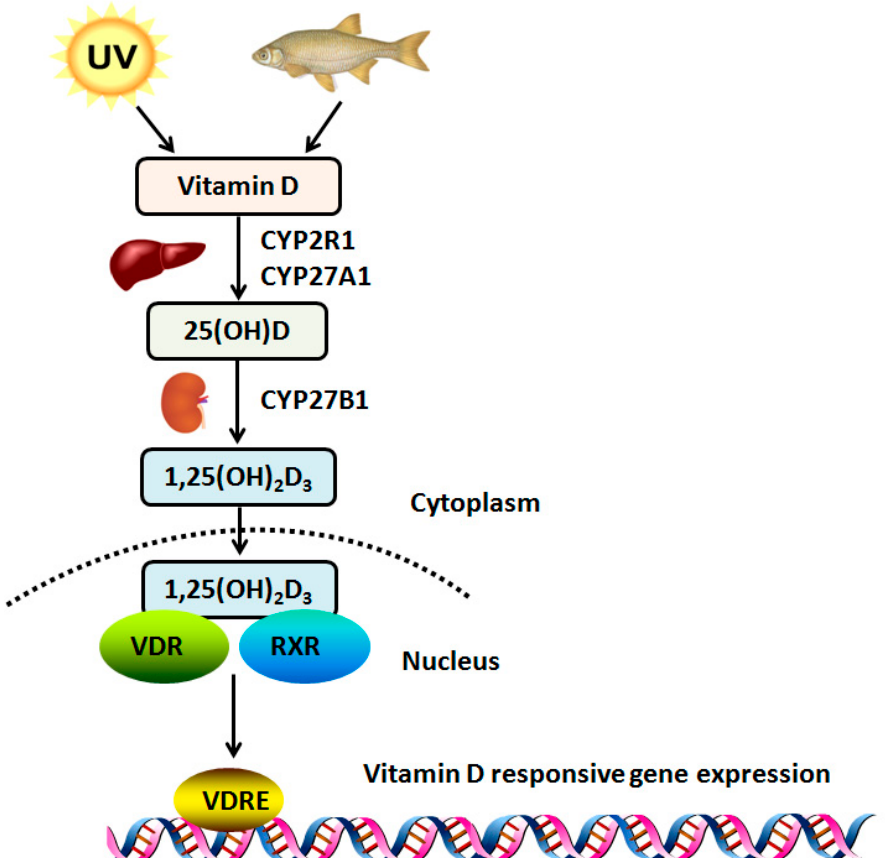
Figure 1. Vitamin metabolism. Vitamin D is synthesized by UVB radiation in the epidermis of skin or obtained from diet, hydroxylated to form 25(OH)D by CYP2R1 and CYP27A1 in liver, further metabolized by CYP27B1 in kidney to 1,25(OH)2D3 (calcitriol), and binds to the vitamin D receptor (VDR) which then heterodimerizes with retinoid X receptor (RXR). The 1,25(OH) 2 D 3 -VDR-RXR complex binds to promoter regions (VDREs) of vitamin D-responsive genes to modulate gene expression.